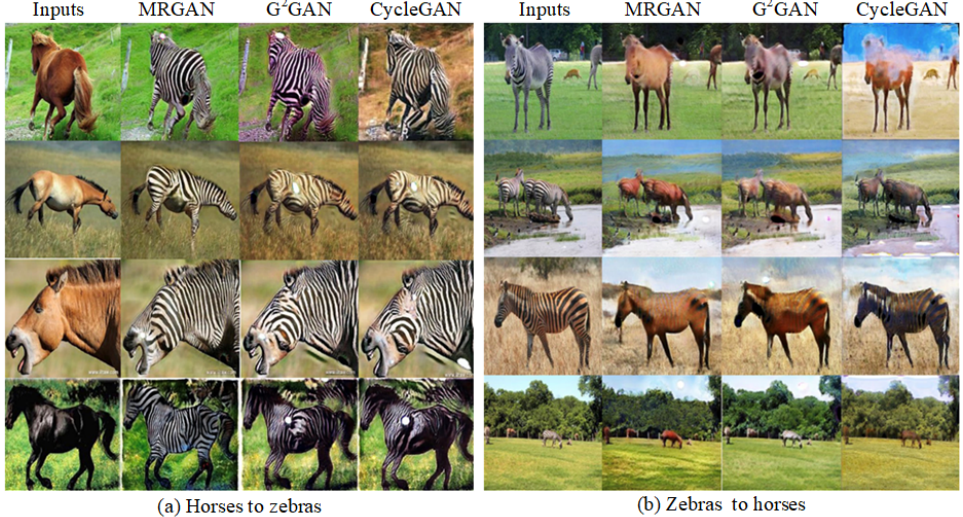
Figure 4. The experimental results on horse 2 zebra for object migration using MRGAN, G 2 GAN and CycleGAN. ( a ) The result images of object migration from horses to zebras. ( b ) The result images from zebras to